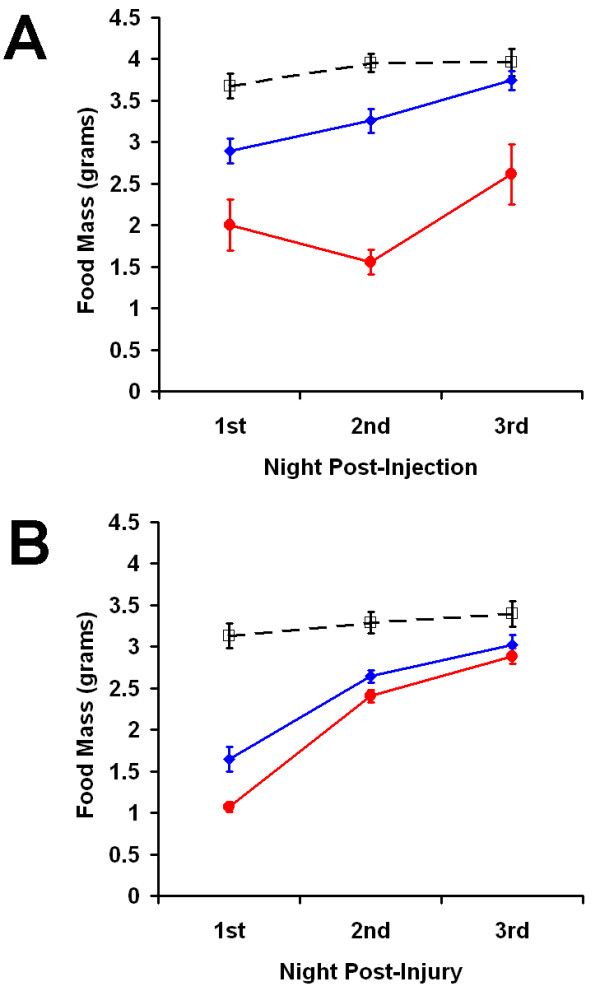
Correlation of insult severity and the magnitude of ileus.Nocturnal food intake for the three nights post-insult was plotted for A. after 3 (blue) or 7 (red) hourly injections of cerulein and B. after laparotomy and either a one minute cecum manipulation (blue) or a 4 minute manipulation of the GIT (red). Corresponding control data is shown for each plot (dashed line). Statistical comparisons are discussed in the text. Values are mean ± SEM.